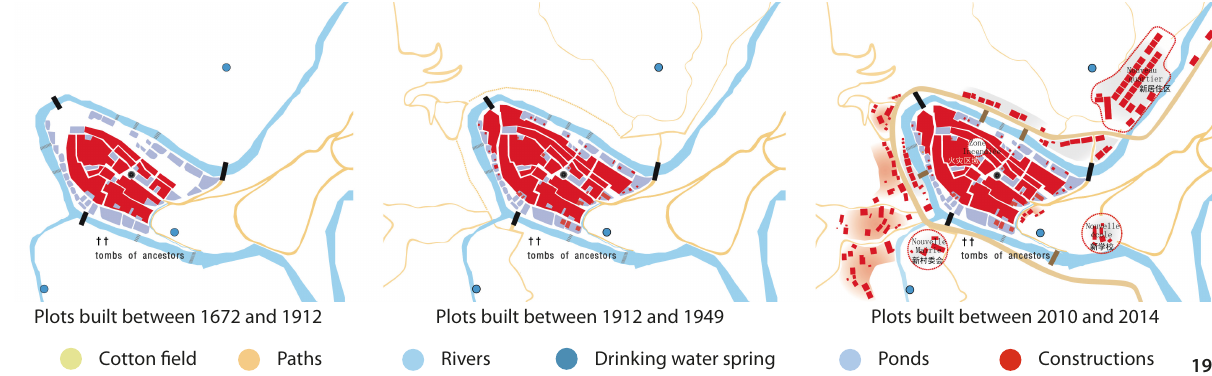
Figure 19 The development of traditional settlements in Zengchong Village and the disorderly spread of new settlements (Source: outcome of Zengchong